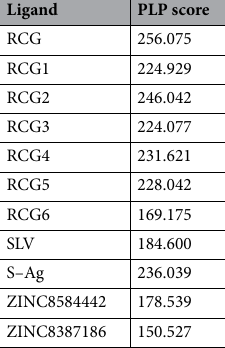
Table 1. Docking PLP score obtained running GOLD. The highest the score the more likely the docking pose is